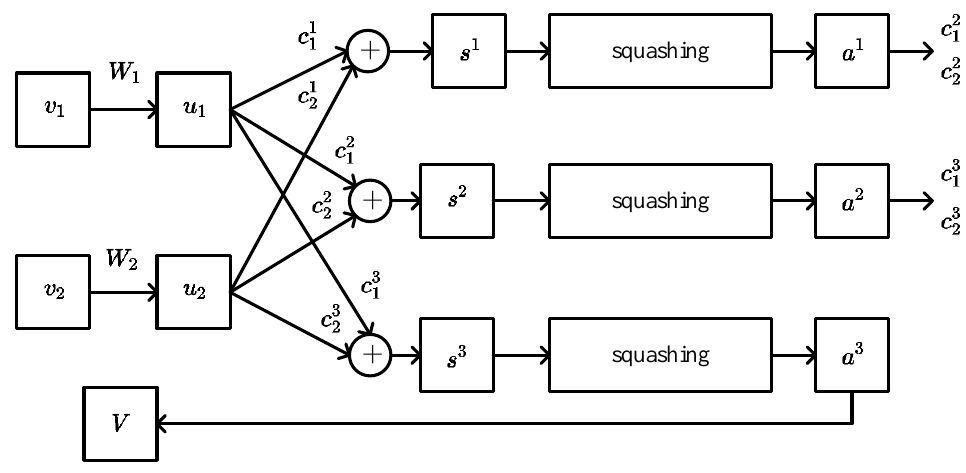
Figure 2. Capsule Network